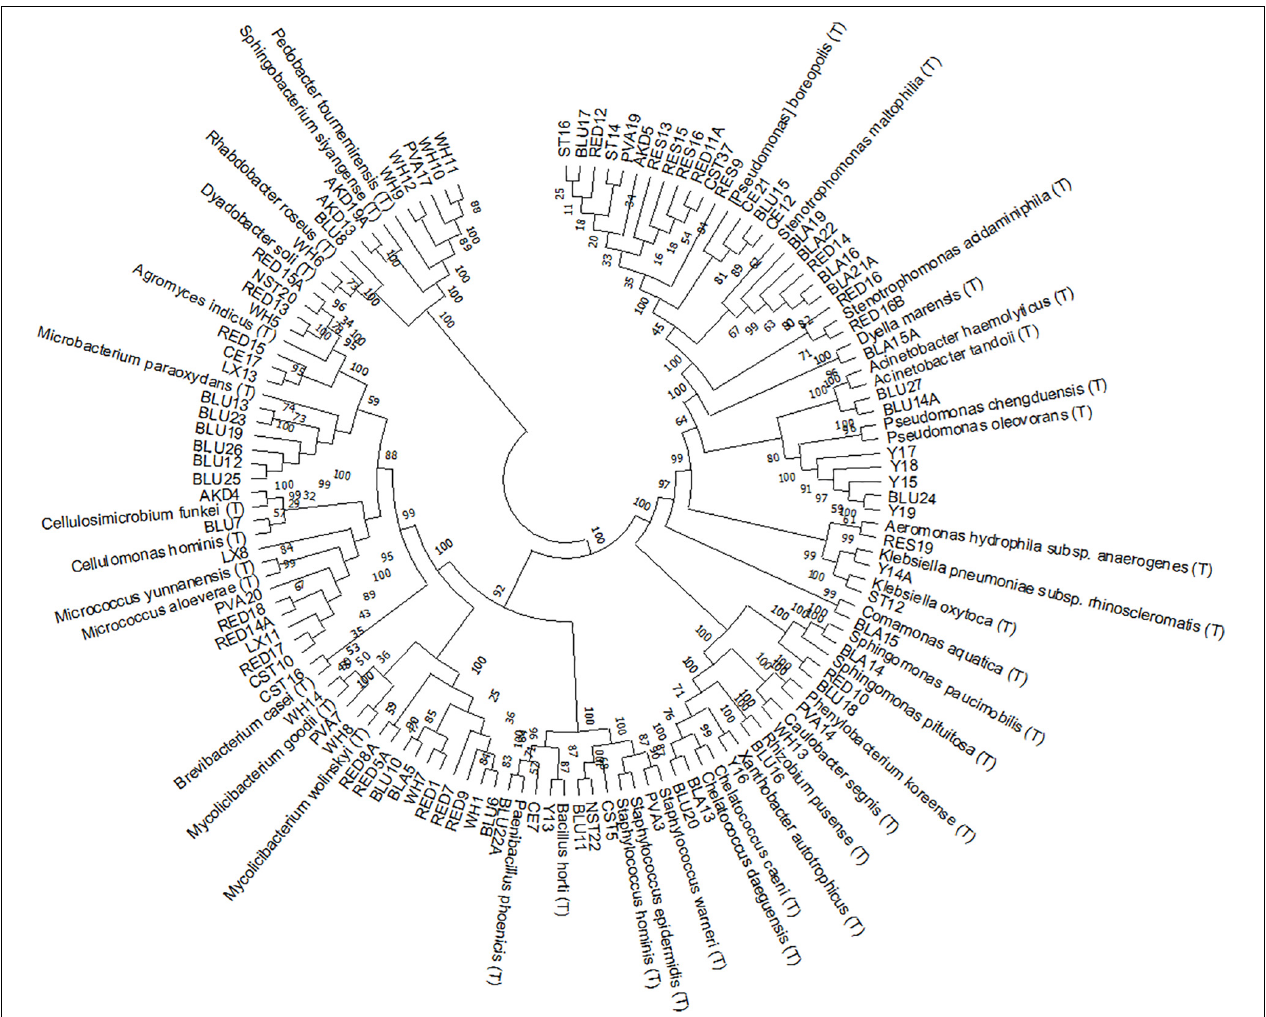
FIGURE 2 | Phylogenetic tree UPGMA (unweighted pair-group method with arithmetic mean) based on 16S rRNA sequences of 95 isolates with their closest type strains. Values at the bifurcations show the bootstrap values of 500 clustering